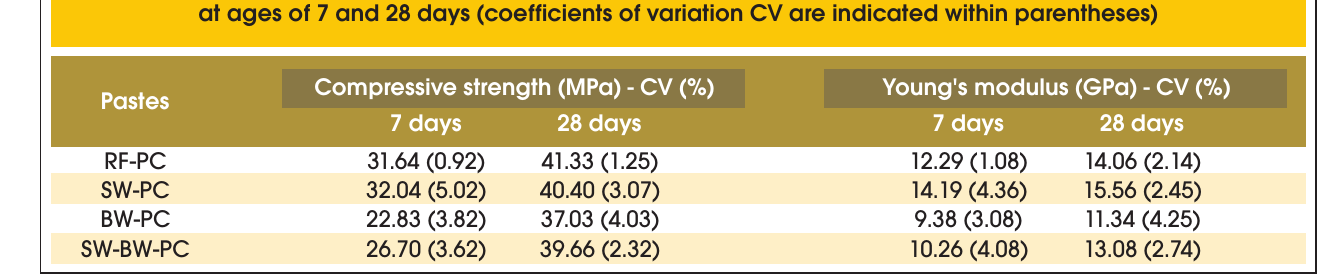
Table 3 – Average values of compressive strength and Young's modulus of the pastes at ages of 7 and 28 days (coefficients of variation CV are indicated within parentheses)